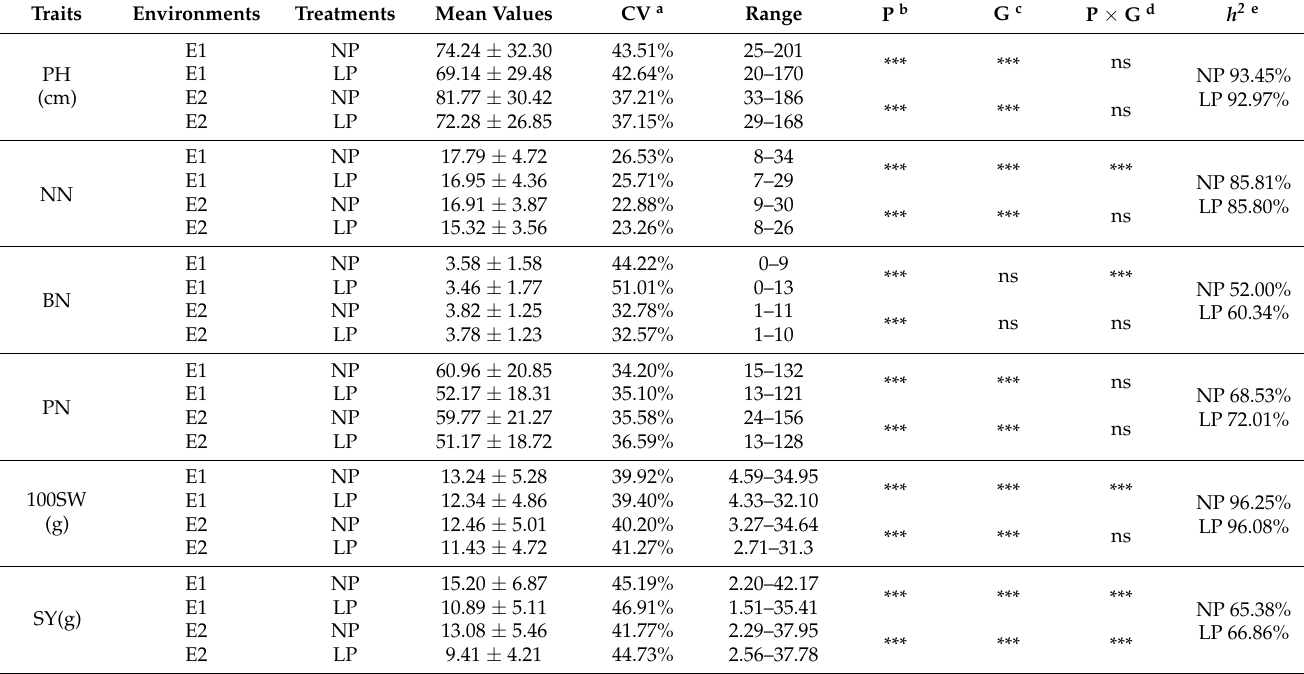
Table 1. Descriptive statistical analysis of the six soybean P-efficiency-related traits at maturity under NP and LP conditions in E1 and